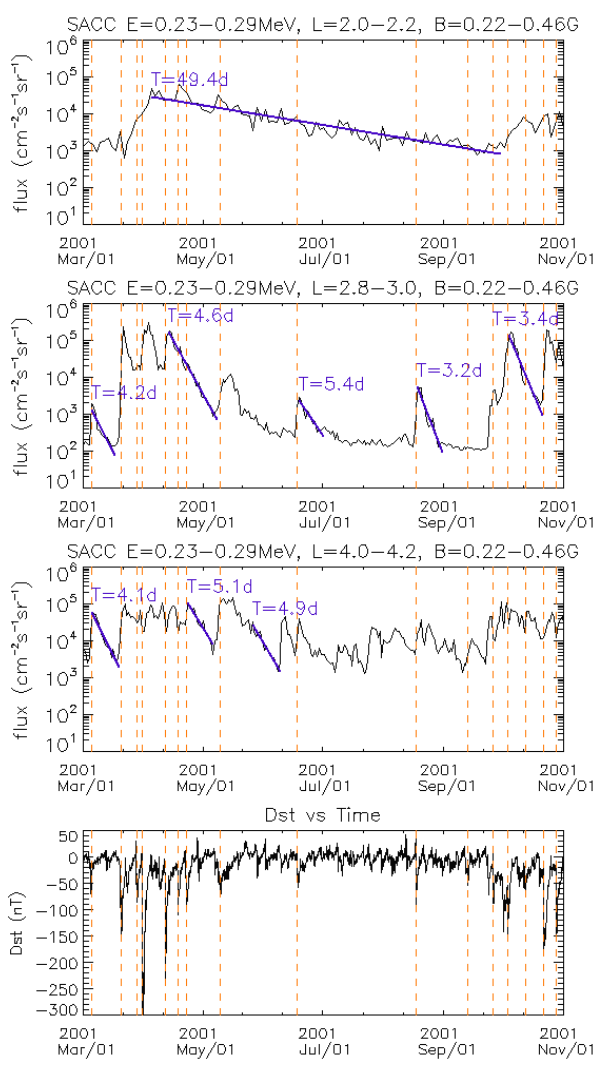
Fig. 1. The three upper panels show the SAC-C/ICARE differential electron fluxes of 0.23–0.29MeV electrons at the indicated posi- tions (given by L and B ) as a function of time from 1 March 2001 to 1 November 2001. The last panel gives the Dst index for the same time period. The orange lines indicate the instant of Dst min- imum (for − Dst min > 50nT). The blue curves indicate the result of the fitting procedure. The corresponding electron lifetimes are also indicated.